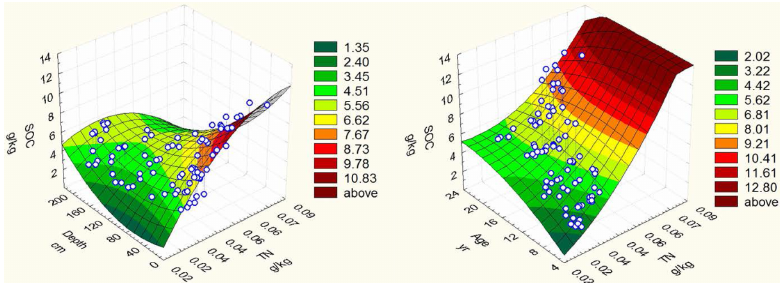
Figure 6. Regression models of soil organic carbon (SOC) and total nitrogen (TN) with the extension of stand age and soil depth.